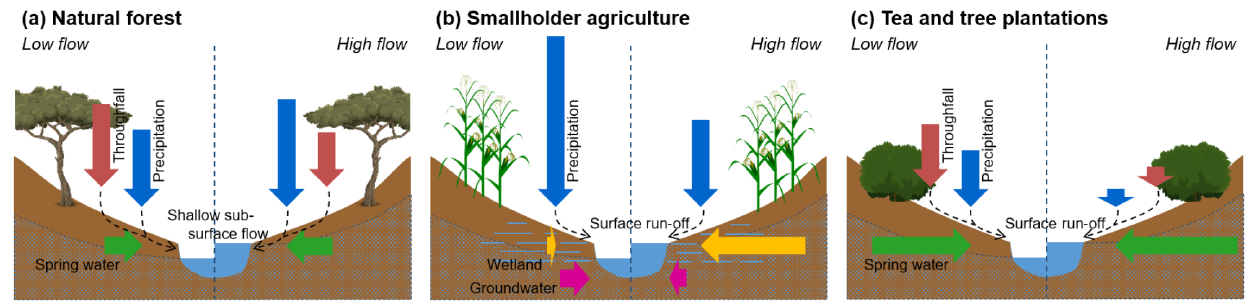
Figure 6. Conceptual model of dominant water sources and flow paths in different land use types during low ( ≤ median discharge) and high flows (>median discharge) in a tropical montane area: (a) natural forest (NF), (b) smallholder agriculture (SHA), and (c) commercial tea and tree plantations (TTP), based on results of endmember mixing and mean transit time analysis in the South-West Mau, Kenya. Arrow length represents the median contribution (%) of each endmember. Black dashed arrows show the most likely pathway for precipitation and throughfall to reach the